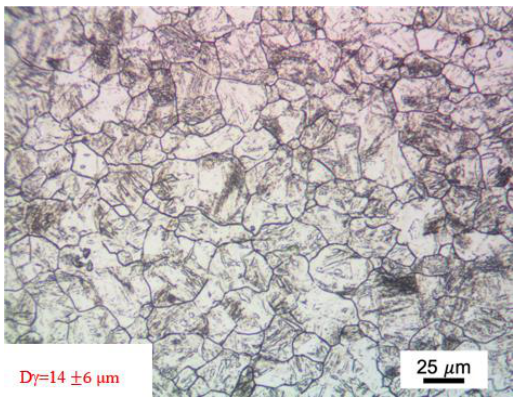
Figure 15. Three-pass reduction of 25% each at 1150, 1100 and 1050°C for ( a ) H4, ( b ) H8 and ( c ) L8.